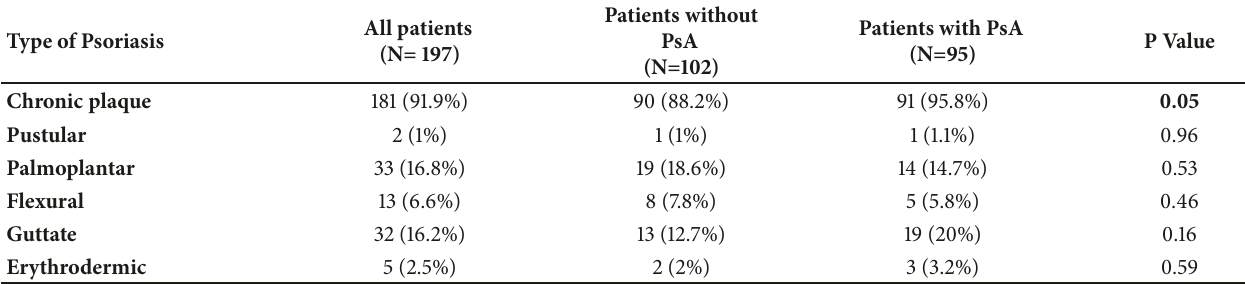
Table 2: Psoriasis phenotypes in the groups studied.